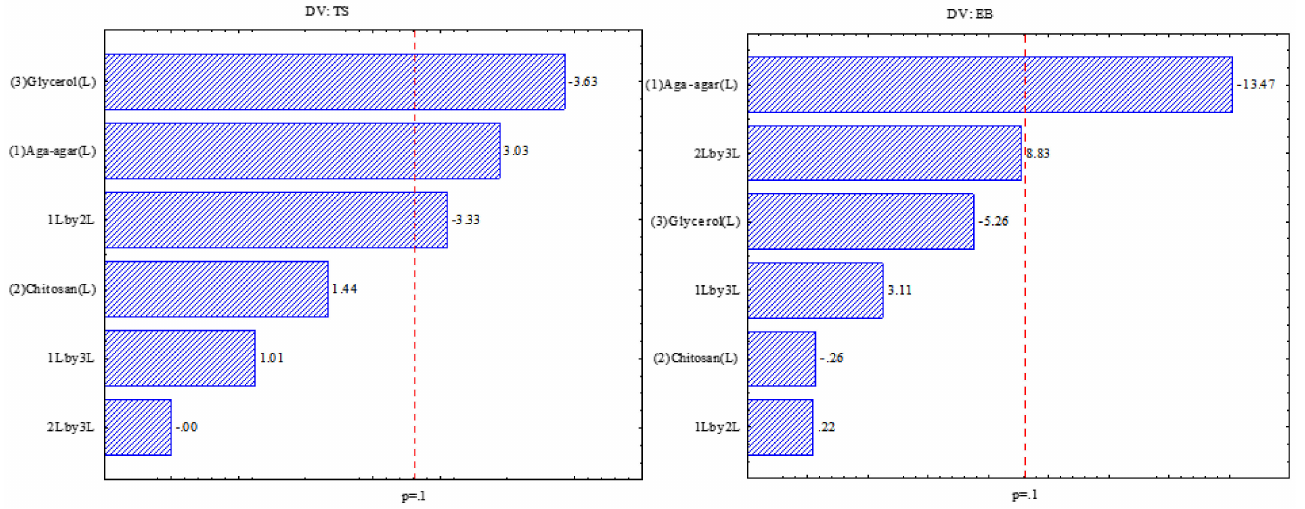
Figure 1. Effect analysis for tensile strength (TS) and elongation at break